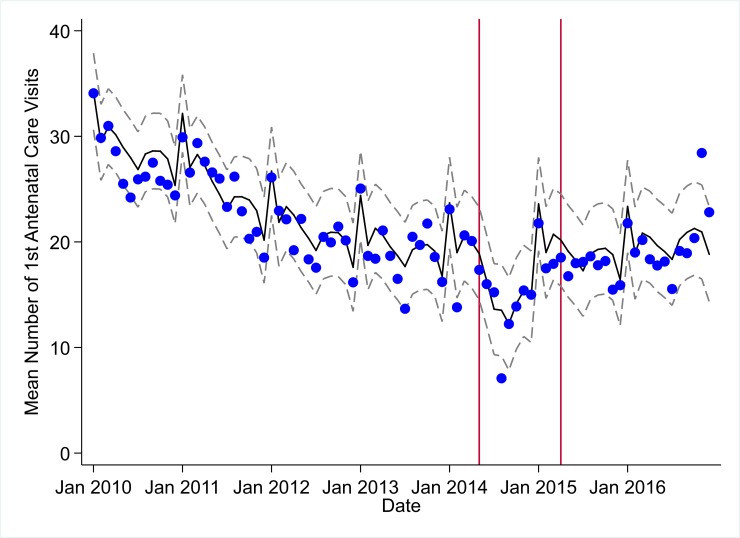
Mean trends and system losses due to Ebola virus disease (EVD) outbreak (June 2014–April 2015) for first antenatal care visits in a census of 379 clinics providing services in Liberia from 2010–2016, excluding Montserrado County.The black solid line represents the fitted mean from a linear mixed model using a segmented regression parameterization, random intercepts and slopes by facility, monthly indicator variables to adjust for seasonality, a fixed effect to adjust for clinic-level catchment area, and an AR(1) structure to account for autocorrelation in residual errors. Gray dashed lines are 95% confidence intervals around the fitted mean. Red lines are placed at the final month before the start (May 2014) and end (April 2015) of the EVD outbreak in Liberia.